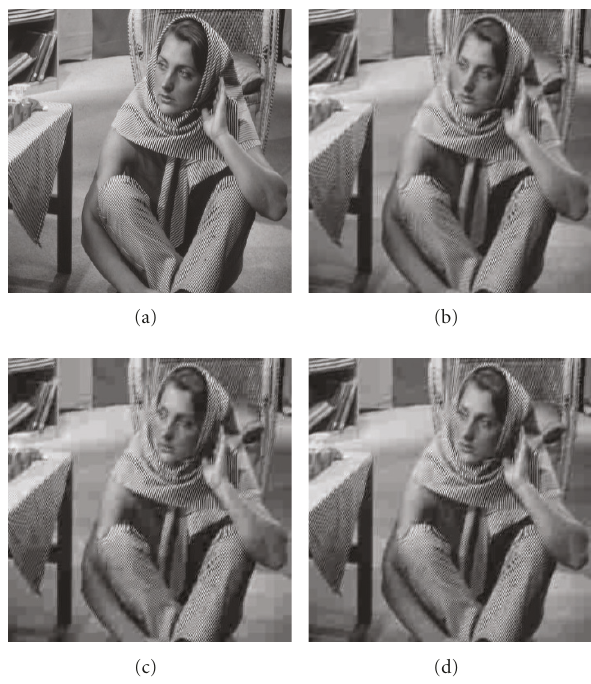
Figure 6: Visual results for the Barbara image of size 512 × 512. (a) Original, (b) encoded using DS-DCT at 0.175 bpp, PSNR 25.21 dB, (c) encoded using DS-WDCT-Qu at 0.175 bpp, PSNR 25.46 dB, (d) encoded using DS-WDCT-Qp at 0.175 bpp, PSNR 25.56